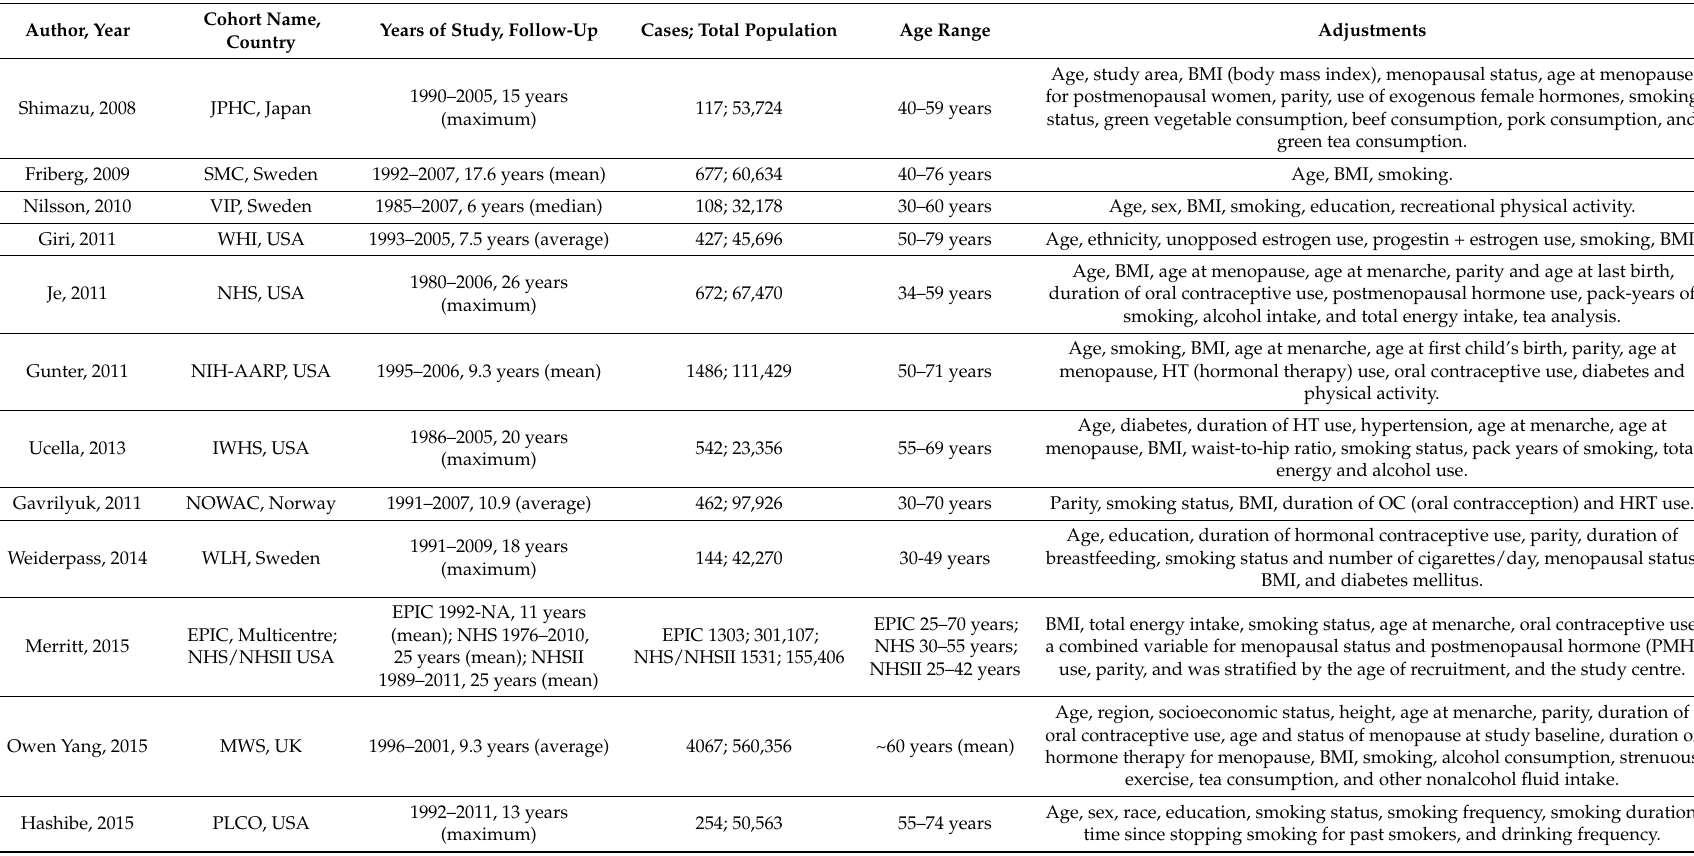
Table 1. Characteristics of the studies included in the